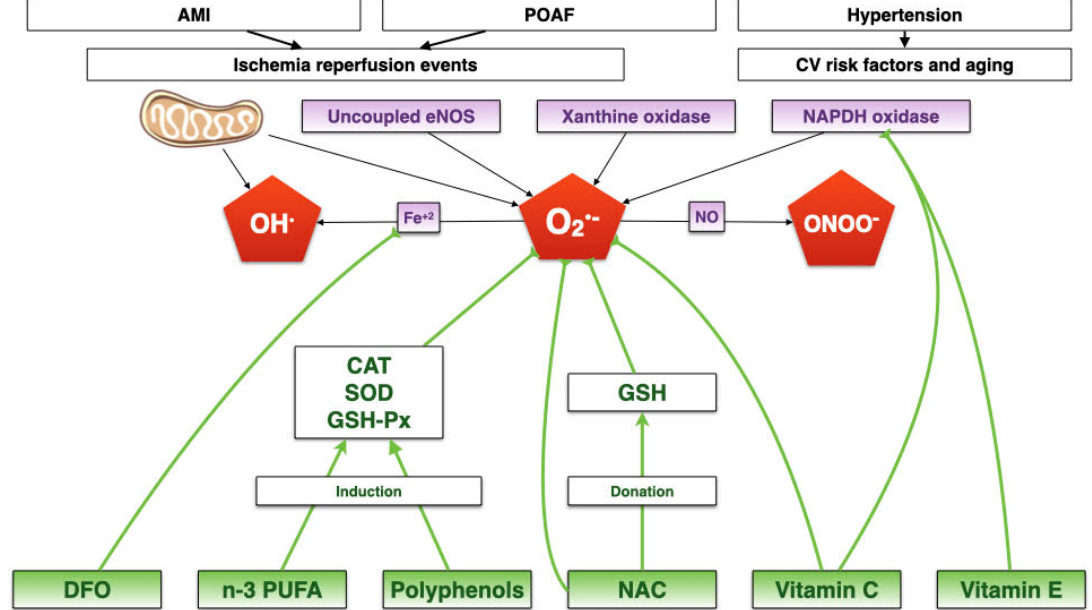
Figure 1. Integrative summary of how oxidative stress could be an underlying mechanism for postoperative atrial fibrillation, acute myocardial infarction, and hypertension. There are four main ROS sources, producing mainly superoxide anion. ROS production can be amplified through the interaction with nitric oxide and iron, to produce peroxynitrite and hydroxyl radical, respectively. CV: Cardiovascular. AMI: Acute myocardial infarction. NO: Nitric oxide. Fe +3 : Free ferric iron. OH: Hydroxyl anion. CAT: Catalase. GSH-Px: Gluthathione peroxidase. SOD: Superoxide dismutase. n-3 PUFA: Polyunsatured fatty acids. DFO: Deferoxamine. NAC: N-acetylcysteine. GSH: Glutathione. POAF: Postoperative atrial fibrillation. ONOO-: Peroxynitrite. OH • : Hydroxyl radical. O2 • -: superoxide anion. eNOS: Endothelial nitric oxide